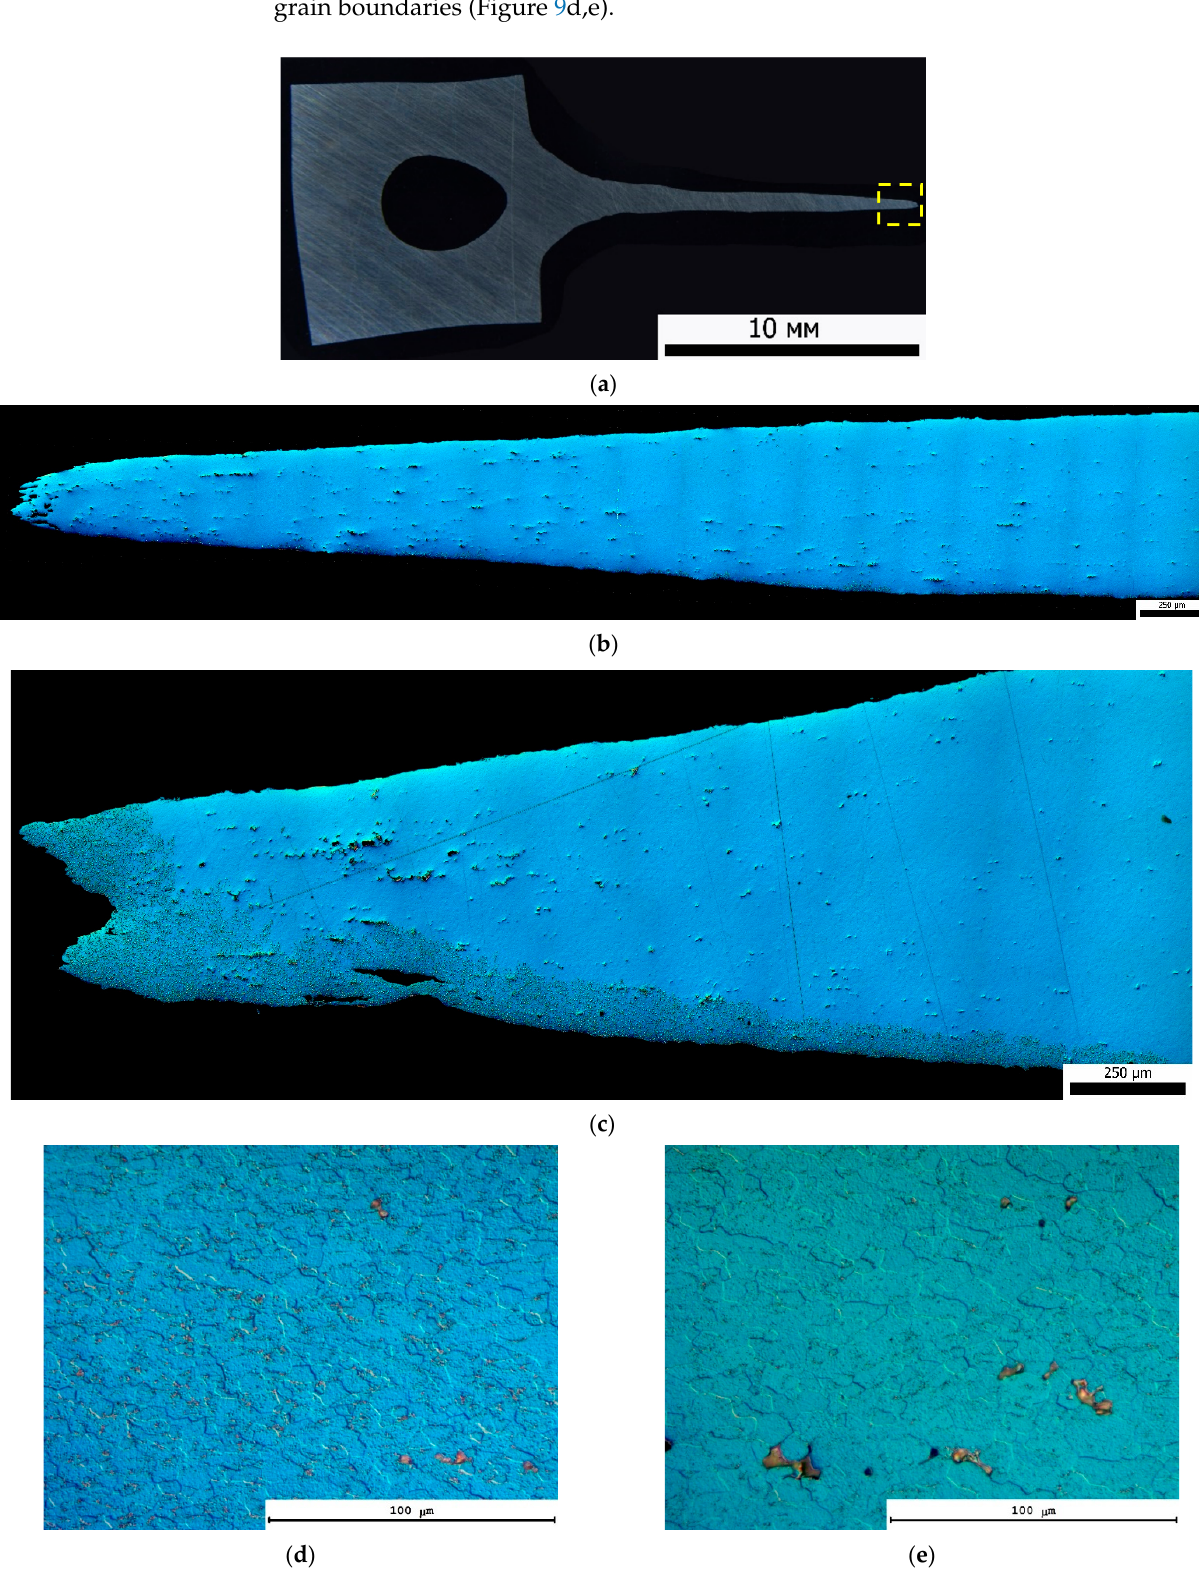
Figure 9. Macrostructure ( a , b , c ) and microstructure ( d , e ) of the samples from series No. 5 after the superplasticity tests at 450 °C ( a , b , d ) and 500 о C ( c , e ). The strain rate 3.3 × 10 − 3 s − 1 . The pores are seen on the sample surfaces after the tension tests, and the sizes and